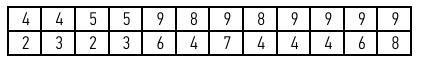
Fig. 4. Representation of upper-level chromosome